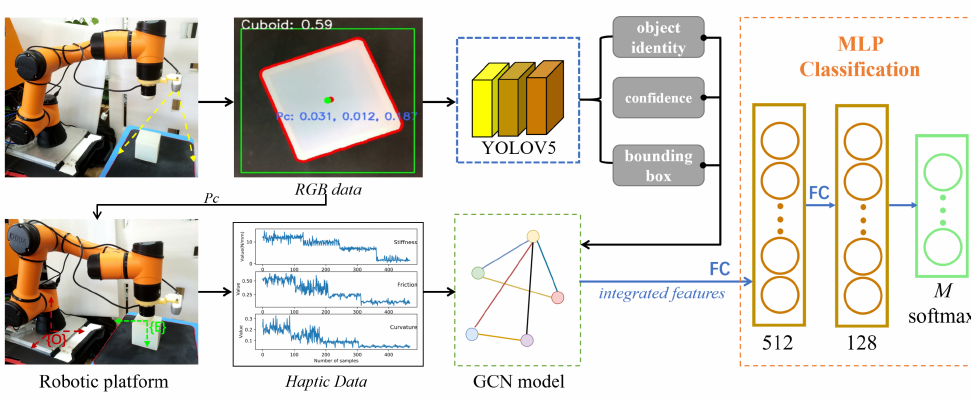
Figure 1. A robot platform utilising a depth camera and a force-torque sensor was assembled. With a certain field of view, the depth camera obtained the RGB data and transferred the data to the trained YOLOv5 model. The output included the confidence and bounding box for each object. On the other hand, the physical properties of the object such as stiffness, surface friction, and roughness were captured through haptic explorations. A confidence threshold ϑ r = 0.8 was set and when the value of the obtained max confidence was greater than it, the result from the vision was trusted and no fusion was required; otherwise, the visual and haptic features would be sent to the GCN model for data integration. Finally, the fused features were sent to the connected multi-layer classifier for recognition, and the identity of the object was decided among all M